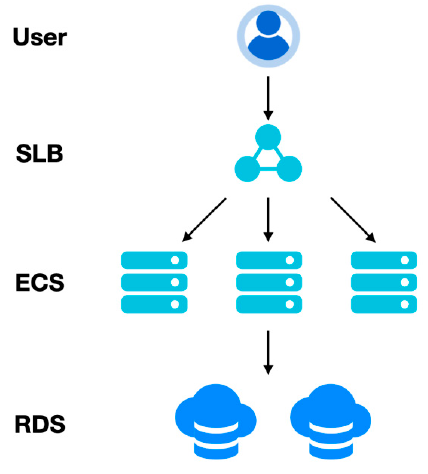
Figure 6. Sample instance pattern.